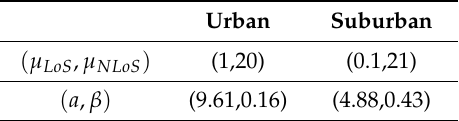
Table 1. Air-to-ground (AtG) propagation parameters.